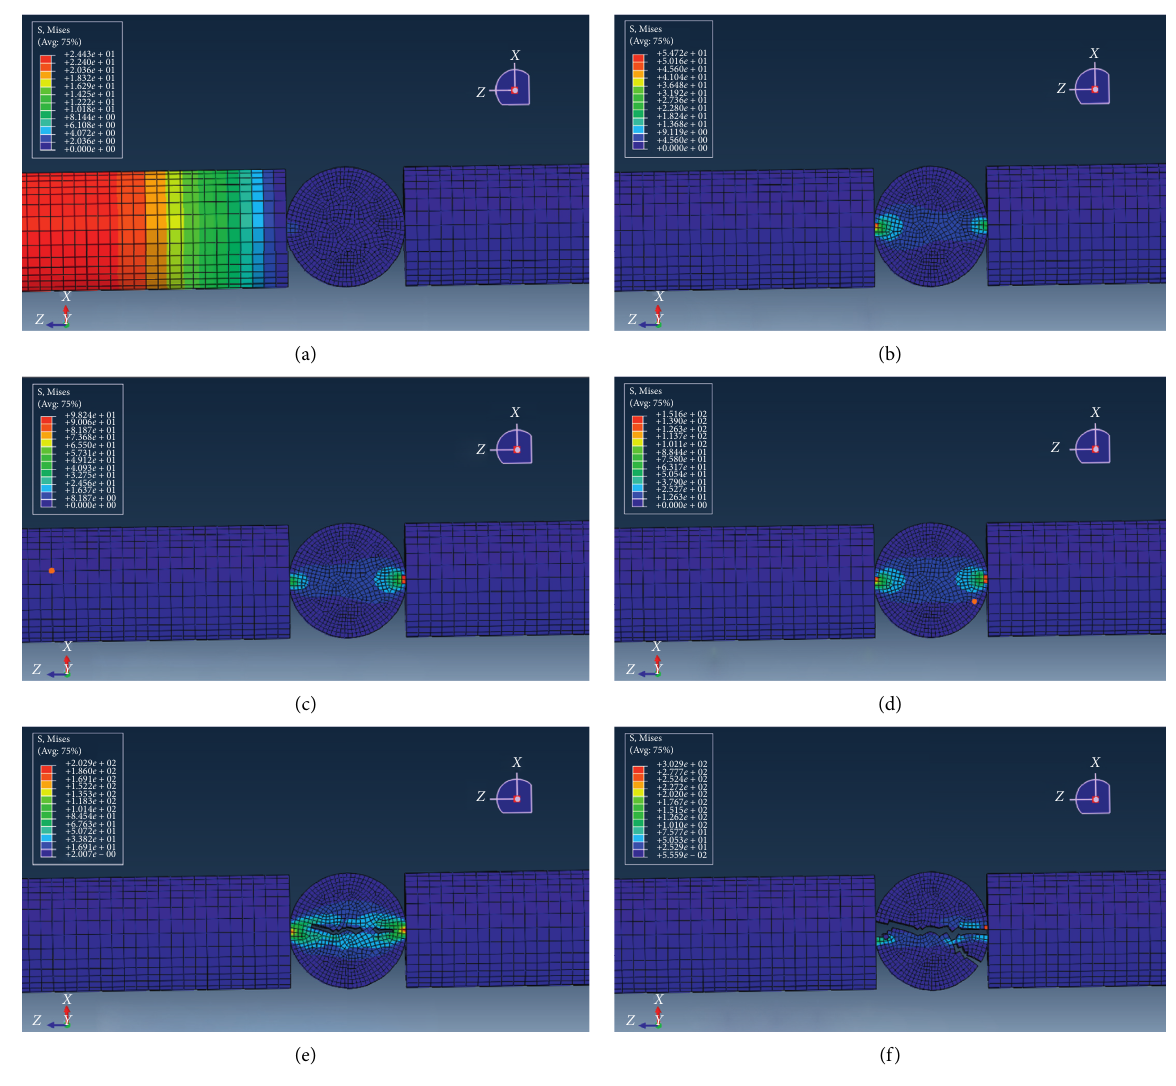
Figure 13: Failure mode of specimen under high speed